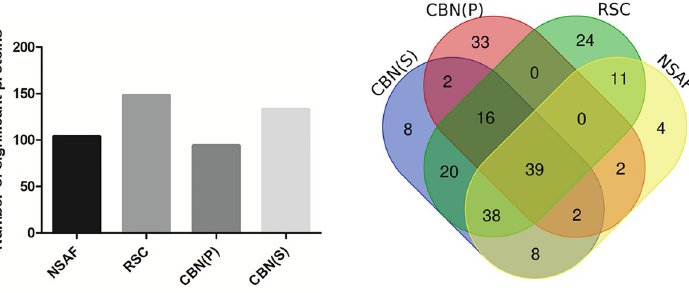
Fig 4. Visualization of identified proteins with all methods in the WT and HD mouse model. (A) The histogram shows for each method the number of proteins that appeared to be both differentially expressed and statistically significant. (B) Venn diagram referred to all proteins. The central area represents the proteins common to all methods.